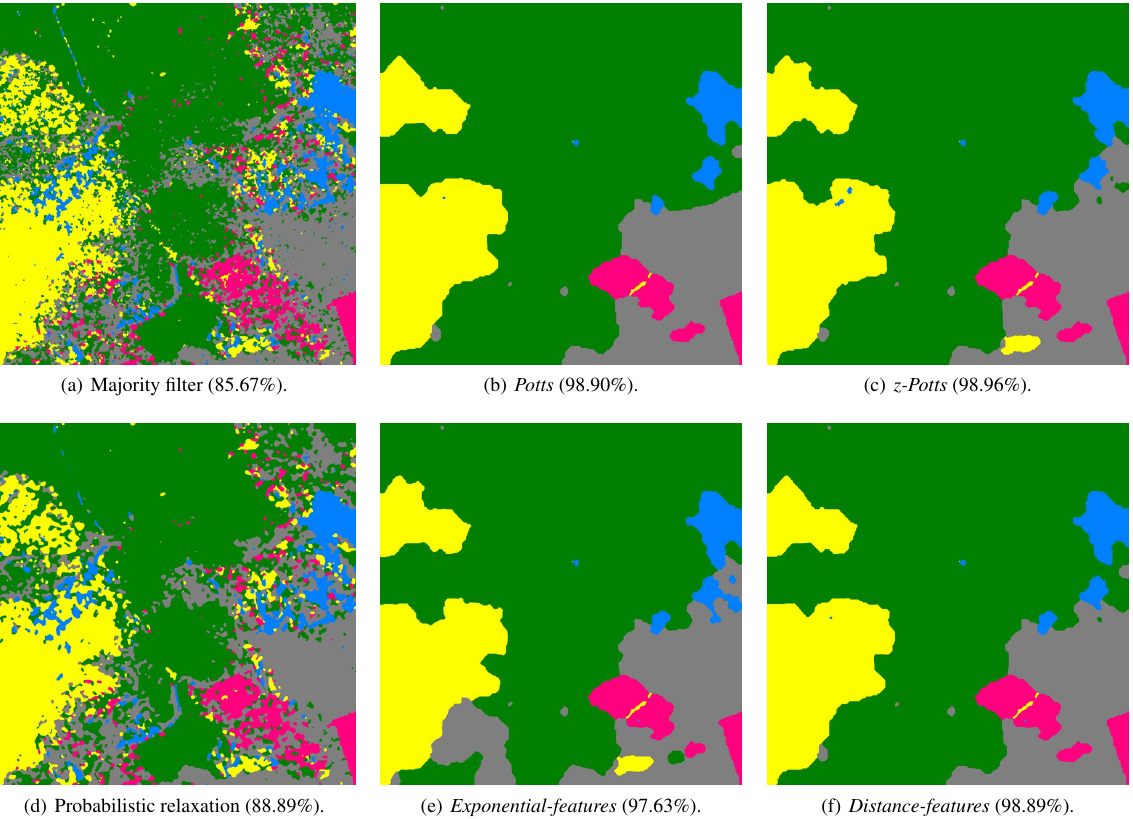
Figure 3. Results of the different proposed models for Area 1, the overall accuracy is specified in brackets. Color codes: beech , deciduous oaks , Scots pine , Douglas fir , fir or spruce